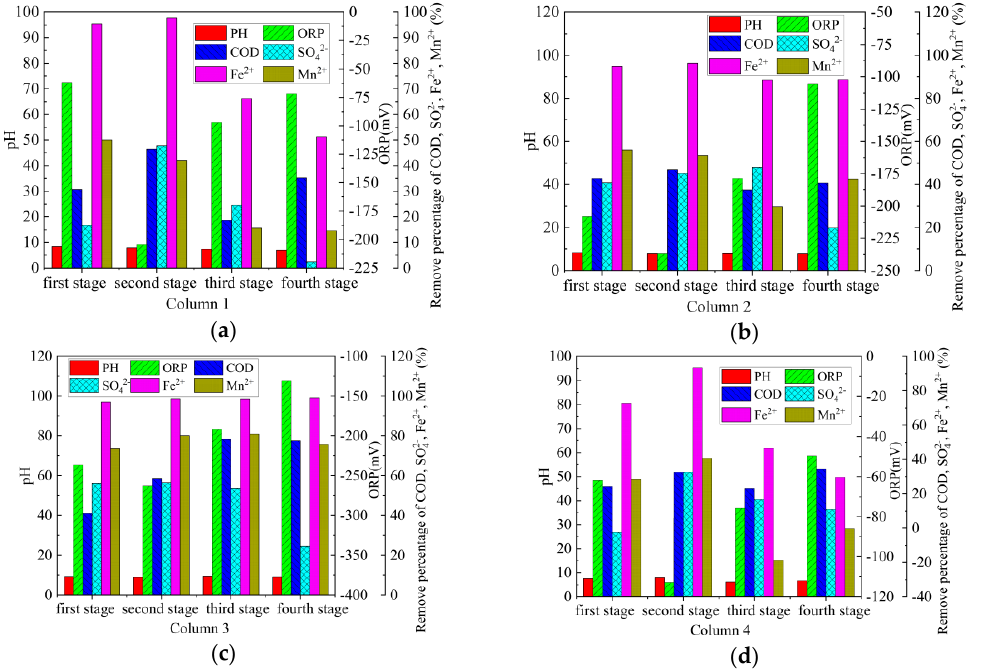
Figure 8. Repair effect of Columns 1–4 on AMD with different pollution load. ( a ) Column 1; ( b ) Figure8. Repaire ff ectofColumns1–4onAMDwithdi ff erentpollutionload. ( a )Column1; ( b )Column2; Column 2; ( c ) Column 3; ( d ) Column 4. ( c ) Column 3; ( d ) Column